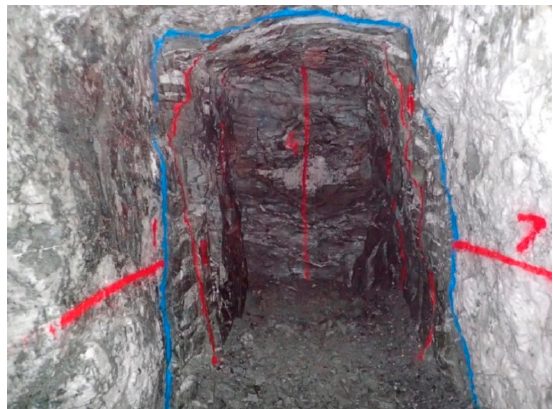
Figure 2. ( A ) Chip-channel sampling. Samples collected from sidewall of shanty drive. Each sample comprises near continuous chips collected across the vein; ( B ) Hand channel sampling of side walls.